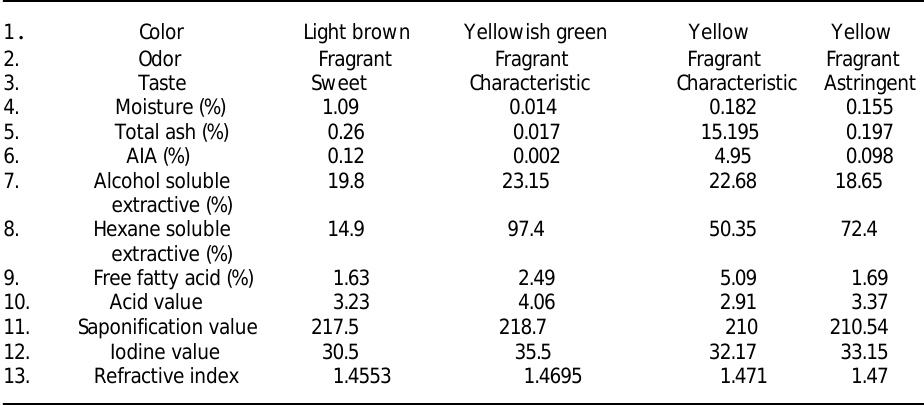
TABLE 1TABLE 1 ANALYTICAL DATA OF GHRITAS